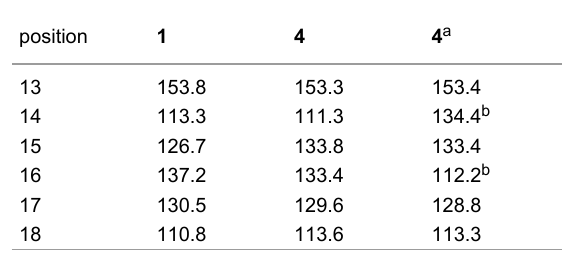
Table 2: 13 C NMR data (600 MHz, DMSO- d 6 ) of the central benzene ring of the isolated compounds 1 and 4 .